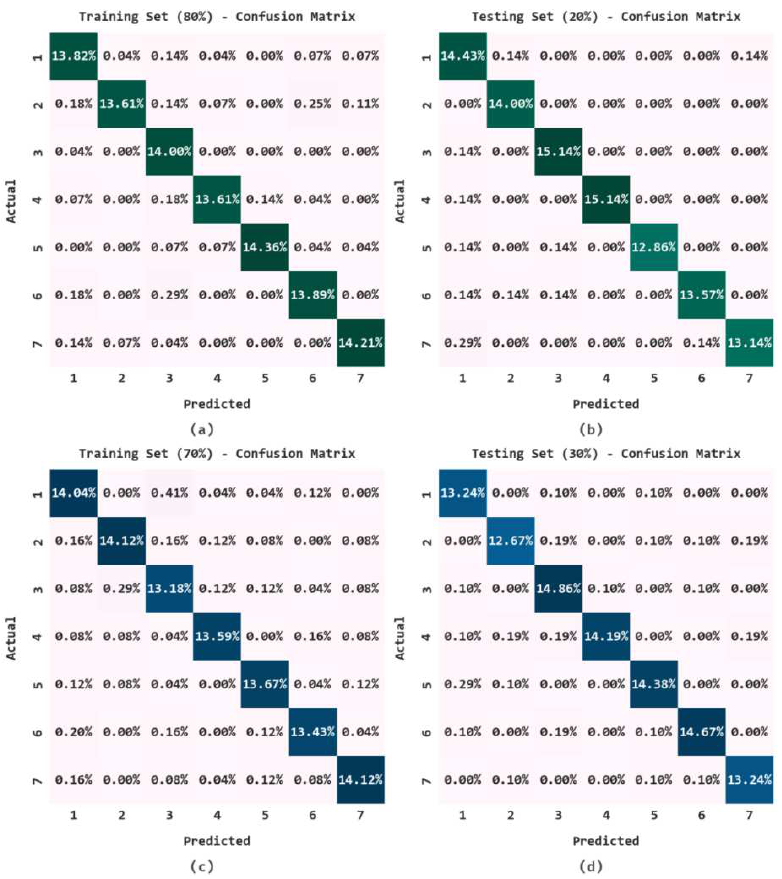
Figure 3. Confusion matrices of CL-DLBIDC: ( a ) 80% of TR data, ( b ) 20% of TS data, ( c ) 70% of TR data, and ( d ) 30% of TS